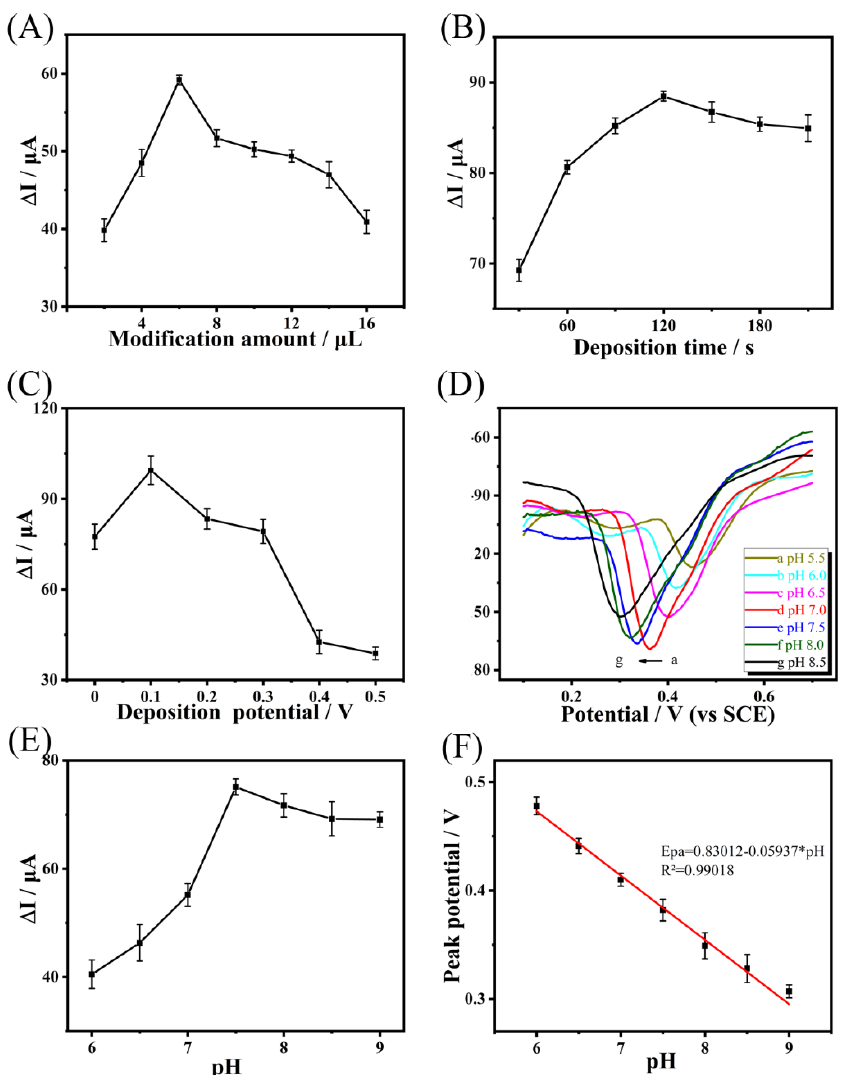
Figure 4. Current responses of the Cu-H-T@rGO/GCE-based electrodes to 0.1 mmol·L − 1 BPA as a function of: ( A ) Cu-H-T@rGO amount on GCE, ( B ) GCE deposition time, ( C ) deposition potential, ( D ) DPV of Cu-H-T@rGO/GCE under the presence of 0.1 mmol·L − 1 BPA at different pH values, changing from 5.5, followed by 6.0, 6.5, 7.0, 7.5, 8.0, to 8.5. Oxidation peak current ( E ) and potential ( F ) values plotted as a function of the corresponding pH values. The data were obtained in 0.2 mol·L − 1 PBS. All data points in ( A – F ) are averages of five measurements, with the errors representing the corresponding standard deviations.